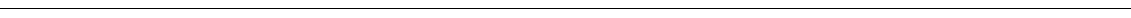
Fig. 2 FZD 6 dimer interface is formed by TM4 and TM5. a – c Presents the homology model of the FZD 6 homodimer interactions involving residues F337 4.55f , A344 4.62f , N346 4.64f , D365 5.41f , R368 5.44f and Y369 5.45f . Rainbow coloring, N-terminus — blue ; C-terminus — red . Main interactions involve TM4 ( green ) and TM5 ( yellow ). a Upper panel : from intracellular side; lower panel : from extracellular side. b side view and c extracellular view with zoom on dimer interface. Residues are shown as sticks in b and c . d Space fi lling model of the FZD 6 dimer and each monomer (side view). Dimer interface area (ca 1,150 Å 2 ) is colored in dark gray . Yellow/magenta identify residues important for dimer interaction as demonstrated by site-directed mutagenesis. For more details, see Supplementary Figs. 2 and 3. e , f dcFRAP analysis of V5-FZD 6 -mCherry and the FZD 6 -GFP dimer mutant showed that the mobile fraction of the dimer mutant is not affected by biotin-anti-V5/avidin surface crosslinking indicating a reduced ability to form dimers. Only data for FZD 6 -GFP in the absence ( gray ) and presence ( red ) of CL are shown. P = 0.1438; t = 1.482; df = 57. N = 23 ROIs before CL; N = 36 after CL from three independent experiments. For analysis of additional mutations see Supplementary Fig. 4. g , h A corresponding FZD 6 -GFP dimer control mutant, where mutations preserving side chain chemical properties were introduced, still interacts with the wt V5-FZD 6 -mCherry as analyzed by dcFRAP. P < 0.0001; t = 4.839; df = 153. N = 75 ROIs before CL; N = 80 ROIs after CL from three independent experiments. i FCS experiments measuring the translational diffusion time ( τ D ) of FZD 6 -GFP and the dimer mutant FZD 6 -GFP in the presence of the porcupine inhibitor C59 (5 µ M, overnight). Data are presented as a scatter dot plot. P < 0.0001; t = 4.552; df = 29. N = 17 cells expressing FZD = 14 cells expressing FZD 6 -GFP; N 6 -GFP dimer mutant from three independent experiments. Error bar gives s.e.m. *** P < 0.001 (two-tailed t